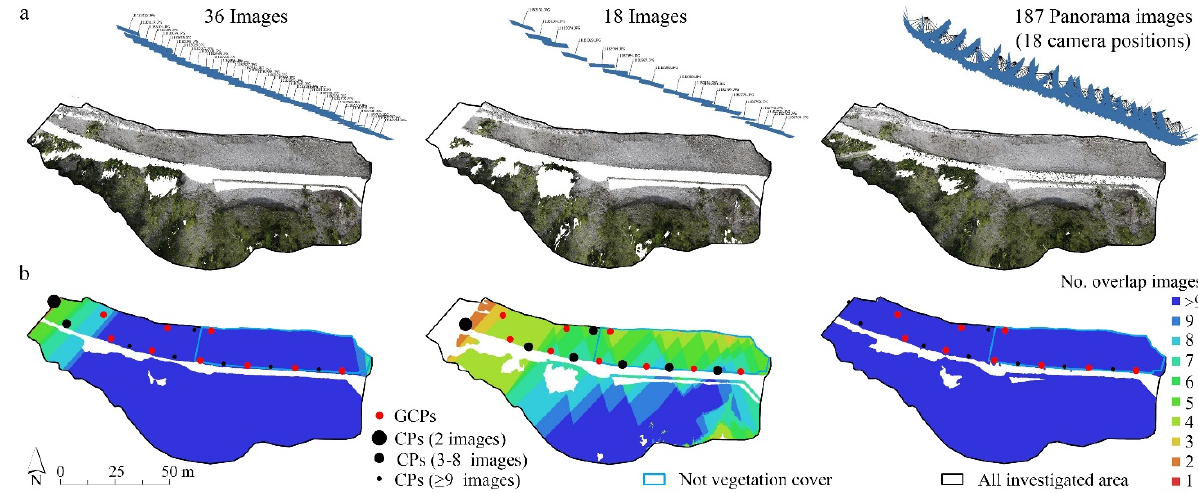
Figure 2: Acquisition geometry for the experimental tests. a) Dense point cloud generated with PS and b) image coverage of the photogrammetric survey for each camera configuration: single (left, center) and panorama images (right). The black points represent the check point (CPs) and their dimension is related to the number of images that view that